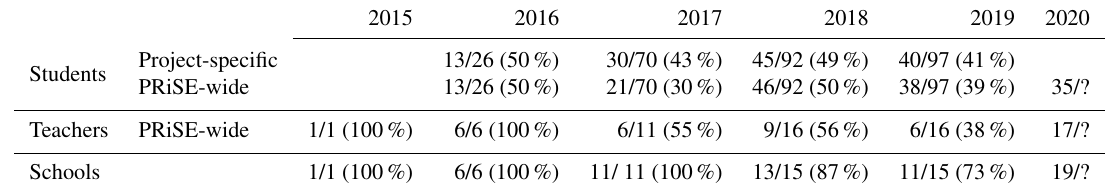
Table 2. Response rates to questionnaires at PRiSE student